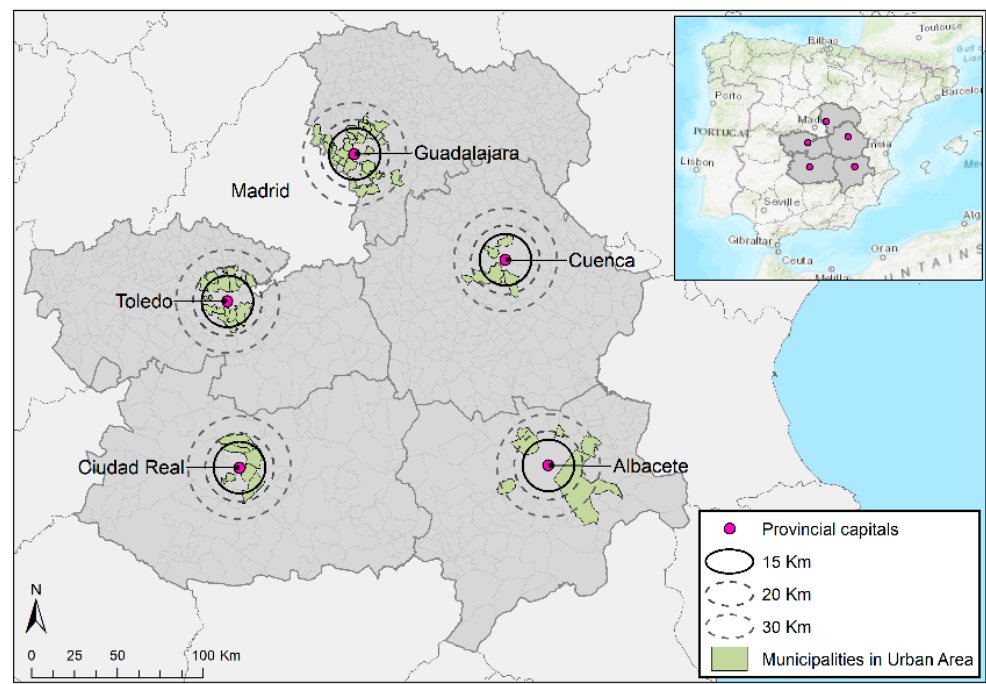
Figure 6. Urban areas of Castilla–La Mancha (Spain). Source: own preparation.